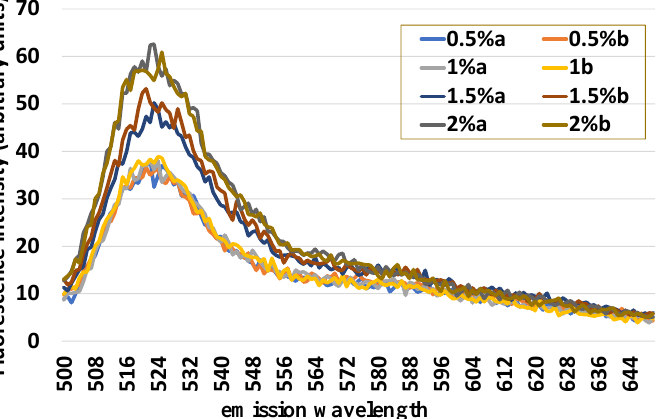
Figure 3. Fluorescence spectra obtained from samples of equine endometrial cells (1 × 10 6 ) mixed with increasing (0.5, 1.0, 1.5, and 2%) quotas of leukocytes, in duplicate, loaded with 2′,7′-dichlorodihydrofluorescein (H 2 DCF-DA) and hydroethidine and excited at 490 nm wavelength.